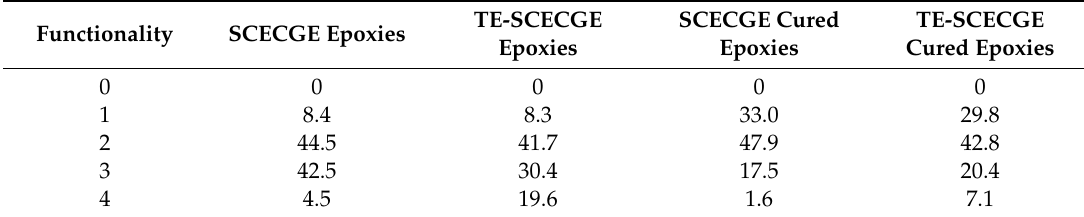
Table 4. Calculated distribution of epoxies and cured epoxies on the SCECGE and TE-SCECGE.